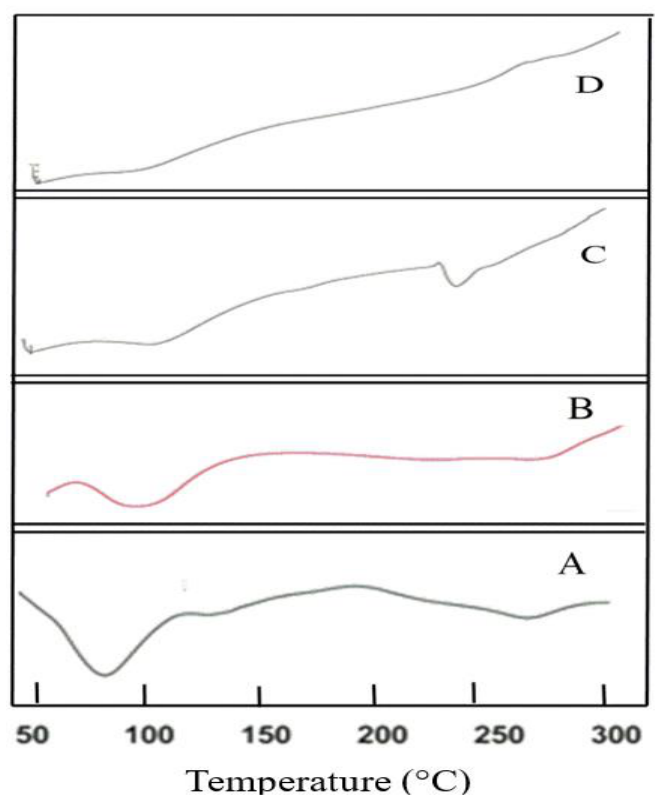
Figure 5. Thermal studies of ( A ) CS, ( B ) CS cross-linked with sTPP, ( C ) EPL and (D) NP6.